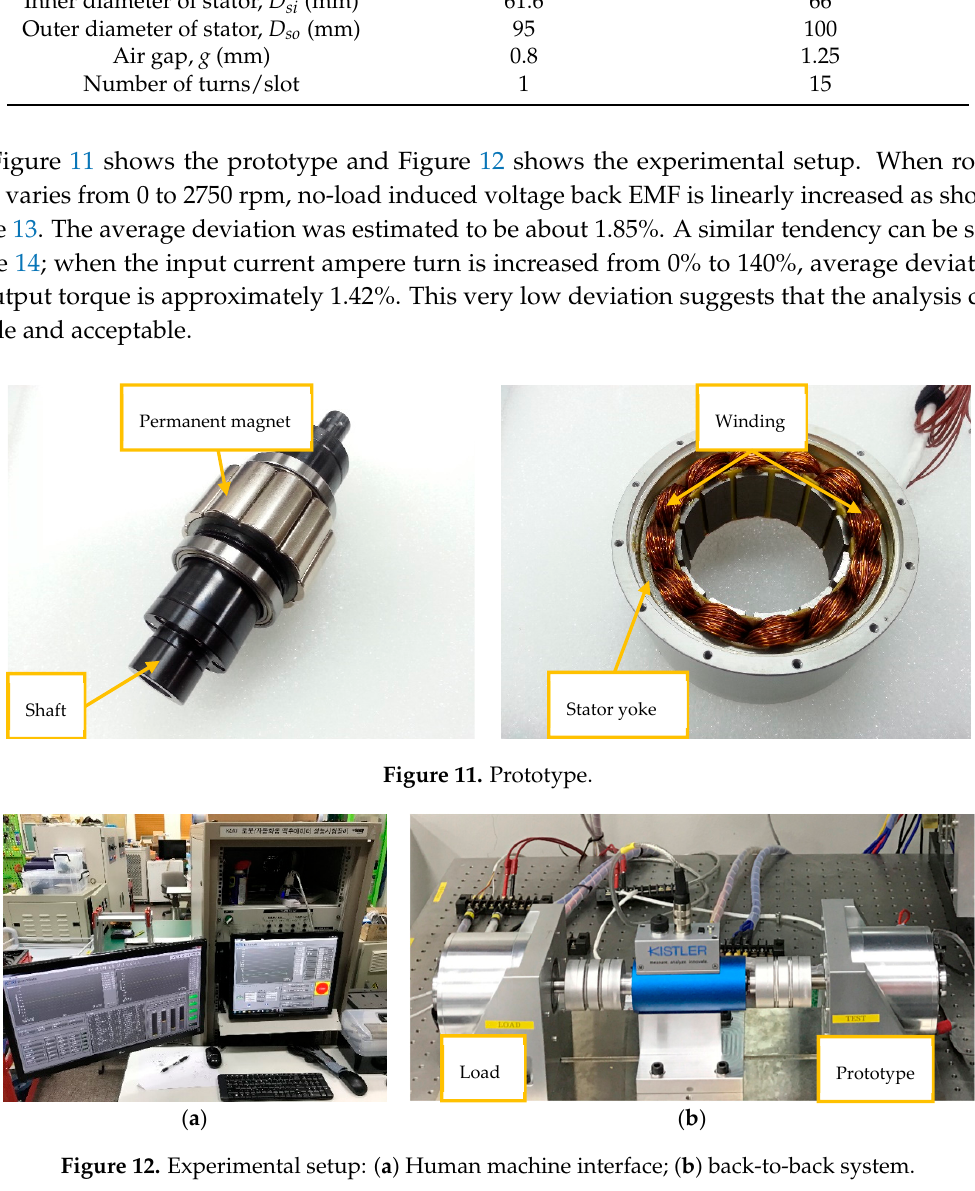
Figure 13. Back EMF for different rotating speeds. Figure 14. Torque for different input currents. 0